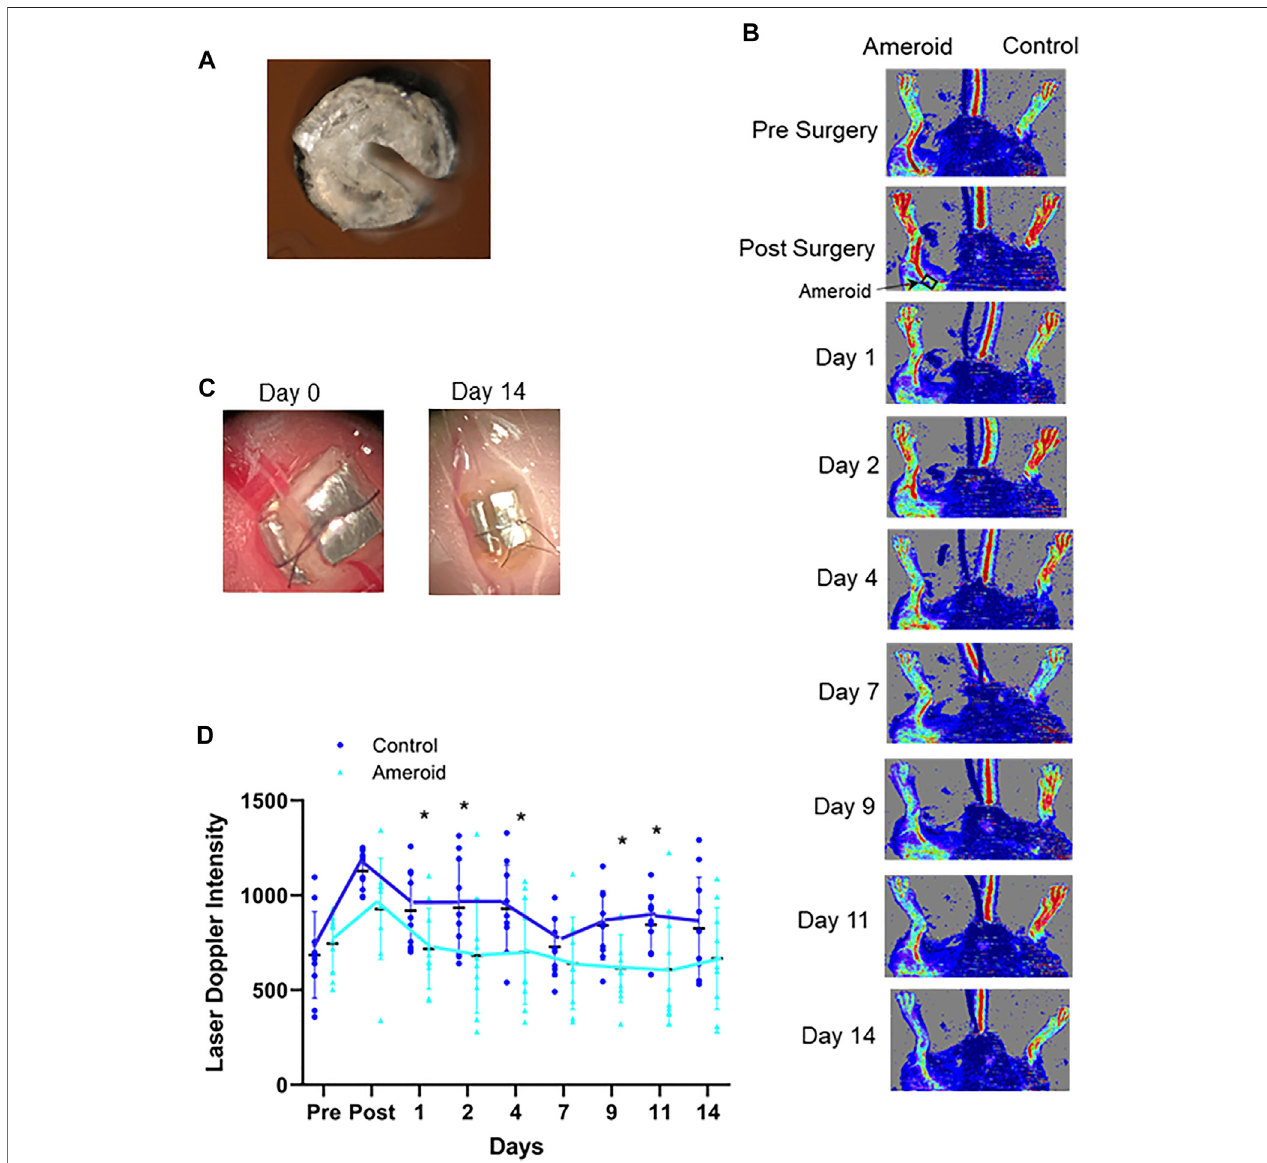
FIGURE 5 | Ameroid constrictor to mimic hindlimb ischemia. (A, C) : A representative 0.25 mm internal diameter ameroid constrictor designed, constructed, and implanted ontheproximalfemoralarterybyourlaboratory. (B) :LaserDopplerImagesofC57Bl/6micetreatedwithanameroidinthefemoral arteryandthecontralateral control. (D) : Blood fl ow measured with Laser Doppler Imaging. Mean ± SD is denoted. The adjusted P-values by the step-down Bonferroni procedure between control and ameroid are p = 1, 0.162, 0.00178, 0,00101, 2.37 × 10 -8 , 0.932, 0.000202, 0.00868, and 0.289,